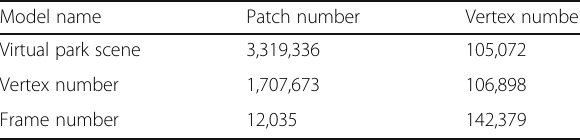
Table 1 Experimental data model